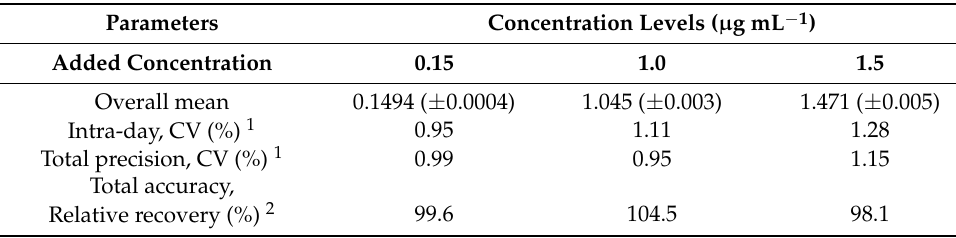
Table 2. Accuracy and precision data of the HILIC-FL method for the quantitation of octreotide ( n = 3 runs in 5 replicates).